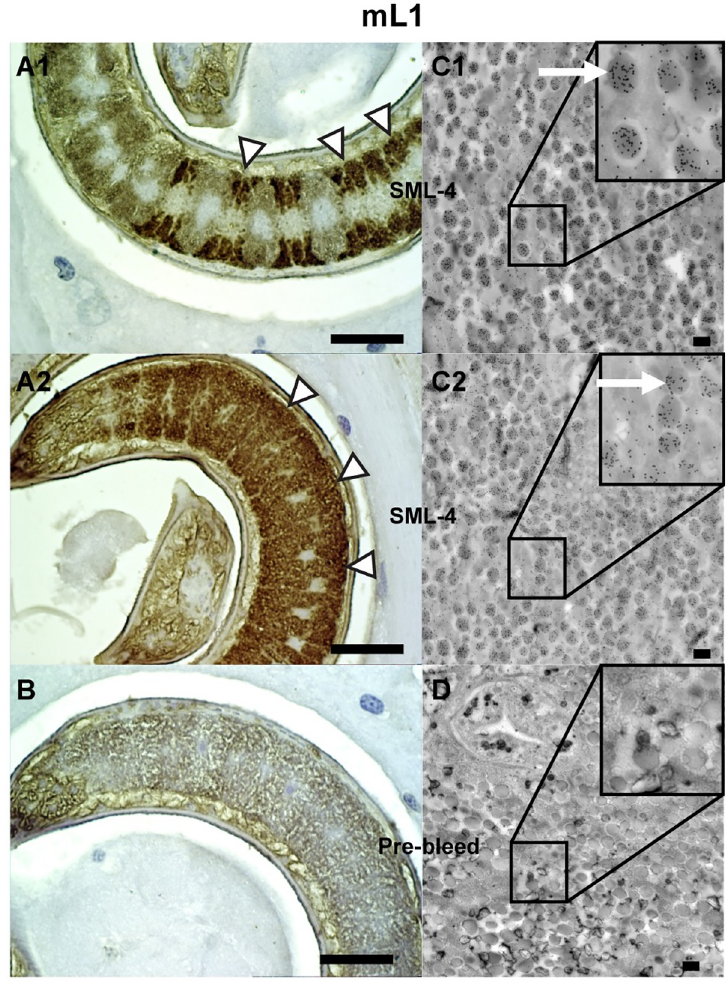
Fig 3. Histochemical and ultrastructural localization of SML-4. (A and B) Formalin-fixed paraffin embedded T . spiralis -infected rat tissue 28 days post-infection probed with anti-SML-4 (A1 and A2) or pre-vaccination control sera (B) and detected with HRP-conjugated anti-IgG and DAB substrate. Sections were counterstained with Mayer’s hematoxylin. The white arrows show areas of staining within the mL1 stichocytes. (C and D) TEM sections of T . spiralis mL1 were probed with anti-SML-4 (C1 and C2) or pre-vaccination control sera (D) and visualized with goat anti-mouse IgG coupled to 15 nm gold particles (black dots). Localization of SML-4 to granules within the mL1 β - stichocytes (white arrows) can be observed. No staining of α -stichocyte granules was observed. Black scale bars in twenty μ m (A and B) and five hundred nm (C and D) are shown in each image. collected from vaccinated mice challenged with a moderate dose was significantly lower com- pared to the control group (General Linear Modeling F = 13.24, p = 0.000; Dunnett’s post- 2,34 test, p < 0.05 for both antigens) (Fig 7A). There was a reduction in larvae recovered that ranged from 43 to 56% in both experiments in mice vaccinated with either protein compared to unvaccinated animals. Upon challenge of mice with a high dose of infectious larvae, vaccina- tion with SML-4 was still protective with a 47% reduction in larvae recovered (one-way ANOVA F = 8.10, p = 0.003; Dunnett’s post-test, p < 0.05), but the SML-5 vaccinated ani- 2,19 mals did not show a statistically significant difference in mL1 recovery as compared with con- trol animals (Dunnett’s post-test, p > 0.05). This indicates that SML-4 is a more effective vaccine candidate when compared to SML-5.